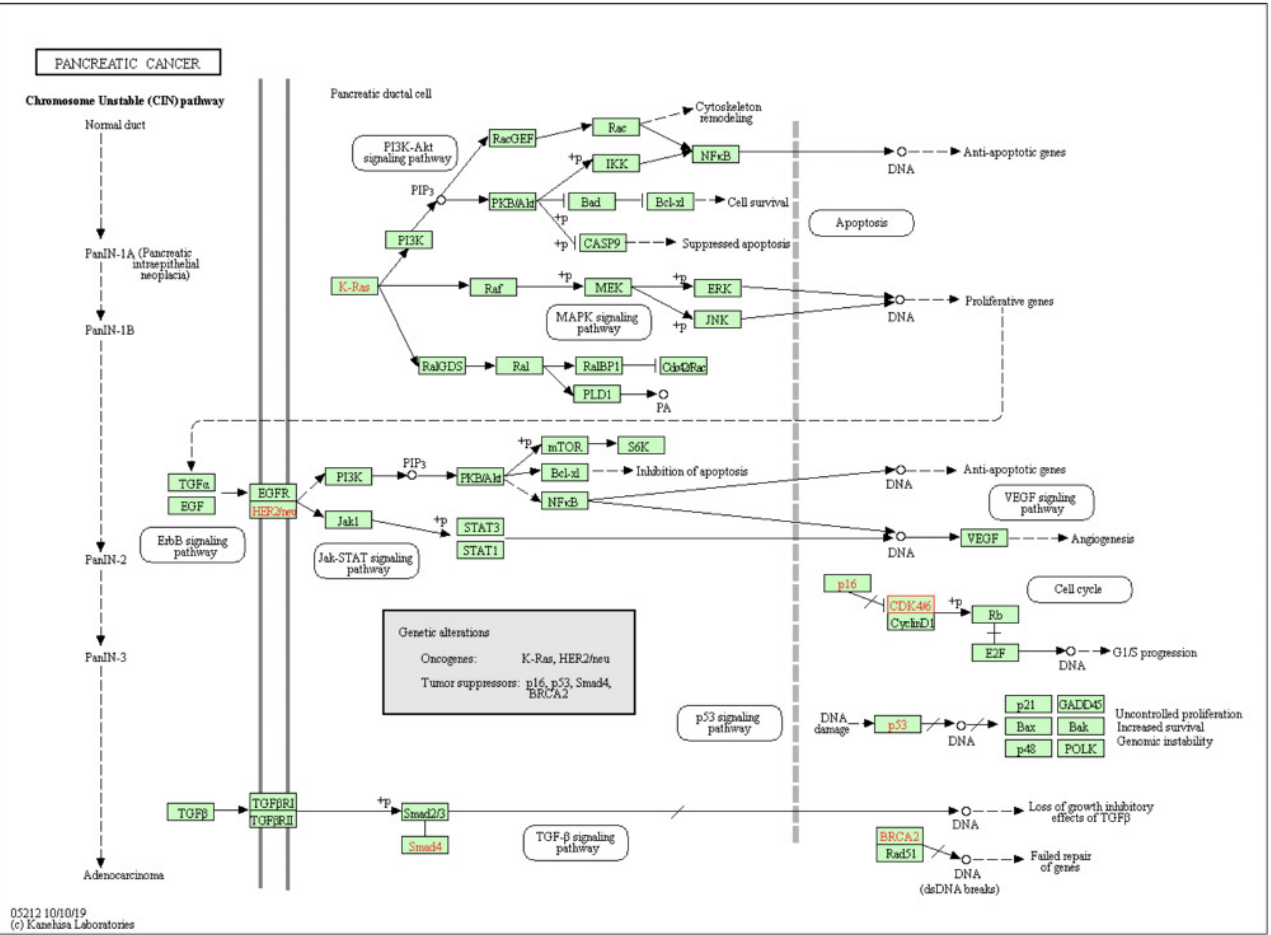
Figure 9. Disease pathway map for pancreatic cancer, where genetic alterations are shown in red. The Chromosome Unstable (CIN) pathway highlights the progression of normal ductal epithelium to infiltrating adenocarcinoma (left) in relation to the accumulation of genetic aberrations (right); the overexpression of HER-2/neu and point mutations in KRAS occur in early events, followed by the inactivation of p16 and the inactivation of p53, SMAD4 and BRCA2 occur in later events. Image taken from: KEGG PATHWAY database (Kyoto, Japan) [25]. Accession number: map05212.